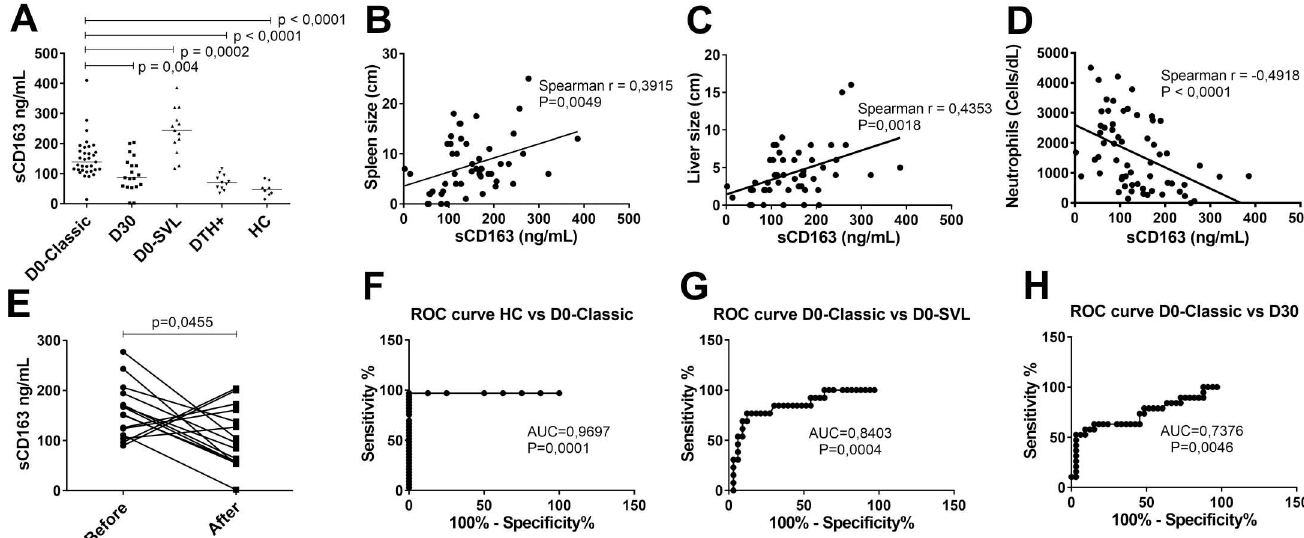
Fig 2. sCD163levels correlate with severityof VL. (A) sCD163 levels were measuredin sera of VL patients of different clinical status. The mean ± SD sCD163levels of patients with classical VL at D0 (D0-Classic, n = 33) (152,1 ± 67,86 ng/mL), D30 (n = 19) (98,79 ± 58,58 ng/mL) and of patients of severe VL at D0 (D0-SVL) (n = 13) (241,5 ± 76,88 ng/mL) were comparedby Mann-Whitney test. Sera from Leishmania -infected individualswithout symptoms or signs of VL (DTH+, n = 11, 72,55 ± 25,68 ng/mL) and healthyindividualsfrom non-endemic regions (HC, n = 8, 49,0 ± 23,71 ng/mL) were includedas control groups. SpearmancorrelationanalysesbetweensCD163concentrations were performed versus (B) spleen size, (C) liver size and (D) neutrophilcount. (E) Paired analysisof sCD163 levels of VL patients before and after treatment (n = 15, p = 0.0455, pairedt test). ROC curves of sCD163concentration comparing HC versus (F) D0-Classic, (G) D0-Classic versus D30 and (H) D0 versus D0-SVL group.